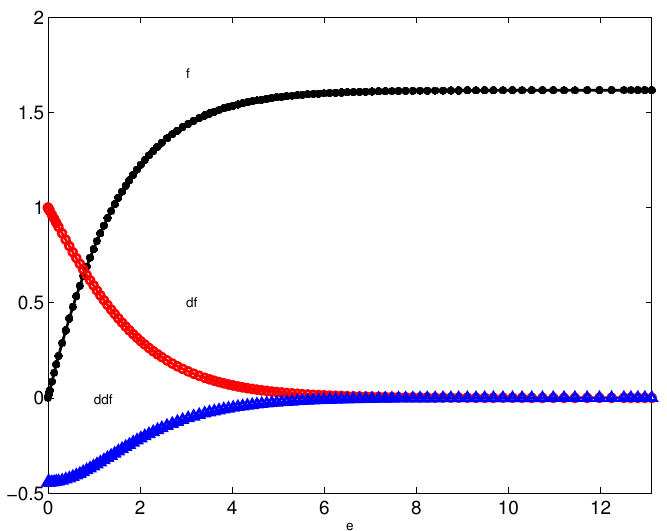
Figure 3. Sakiadis solution via the iterative transformation method